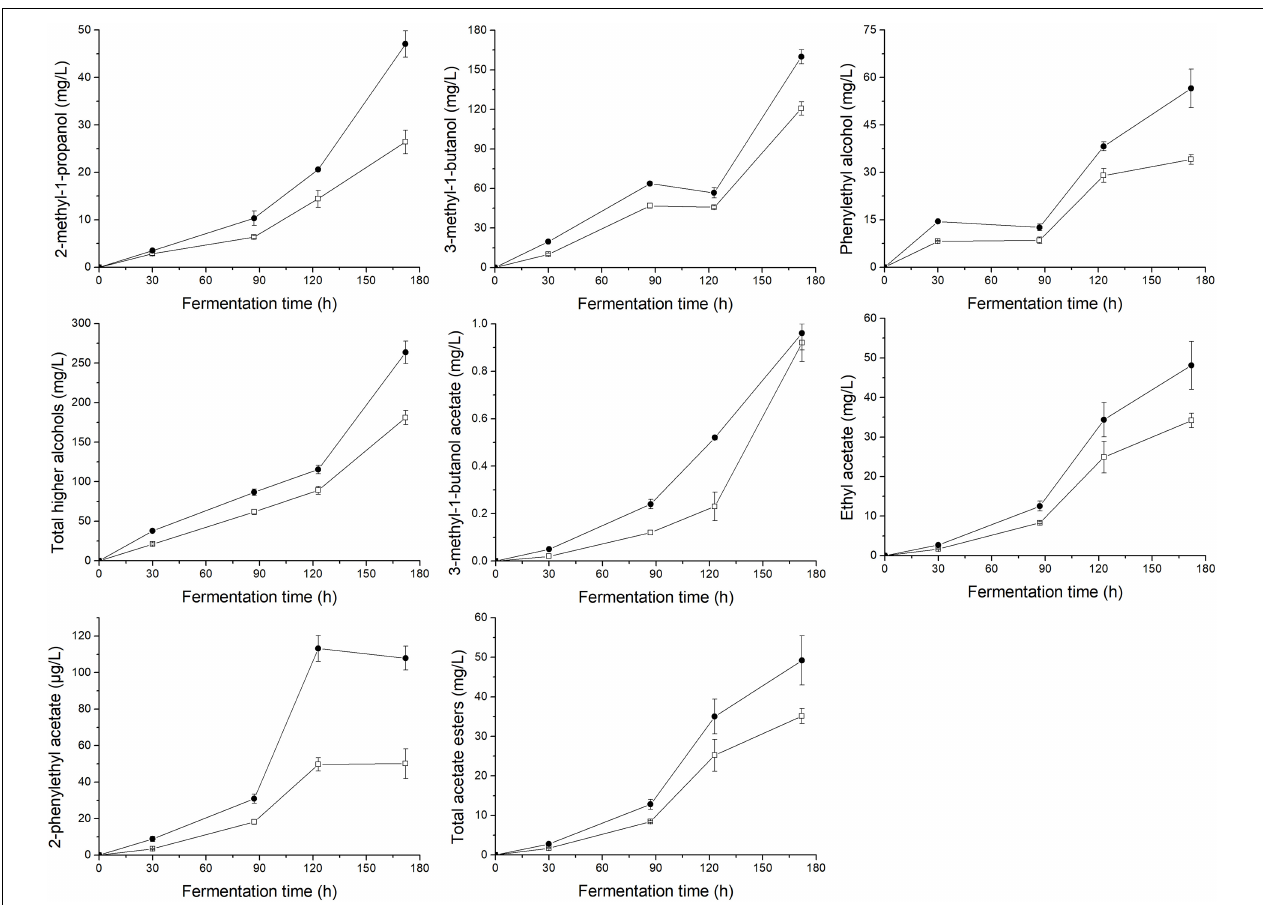
FIGURE 3 | Profiles of the major higher alcohols and total content of higher alcohols, acetate esters and total content of acetate esters during the fermentation of MS300 medium with high